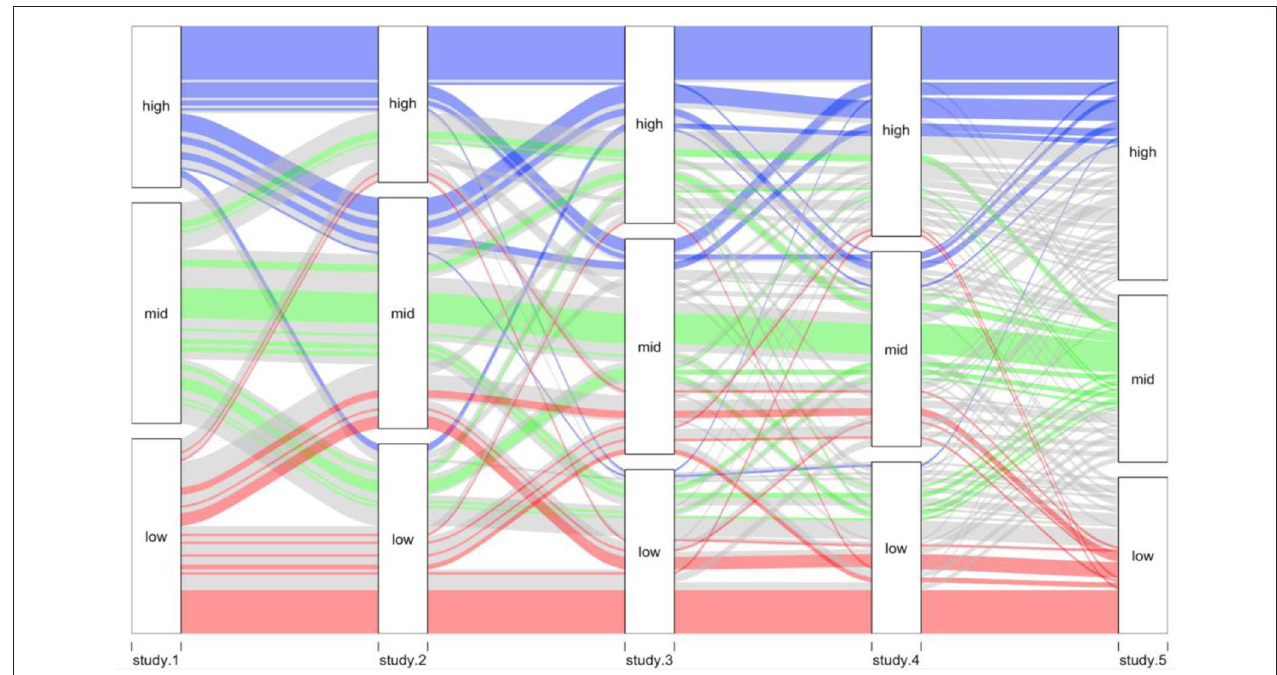
FIGURE 4 | Plot for each participant’s level of SDMS over all five measurements. Each line represents each individual’s SDMS score; the lines are color-coded with respect to the initial and final level of SDMS: participants low in SDMS ( < 4) are marked in red, those moderate in SDMS are marked in green (4 < x < 5), and those high in SDMS ( > 5) are marked in